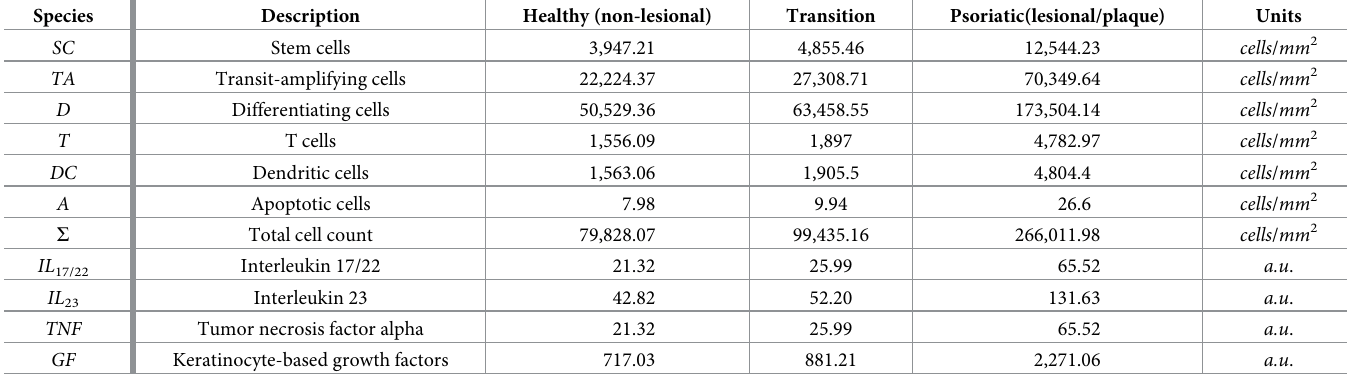
2.1.1 Epidermis composition. Fig 1c shows the epidermis composition in the three steady states of our model (the precise values are reported in Table 2). The total number of cells per unit area of human epidermis is different from person to person, and varies across the human Table 2. Steady states of the